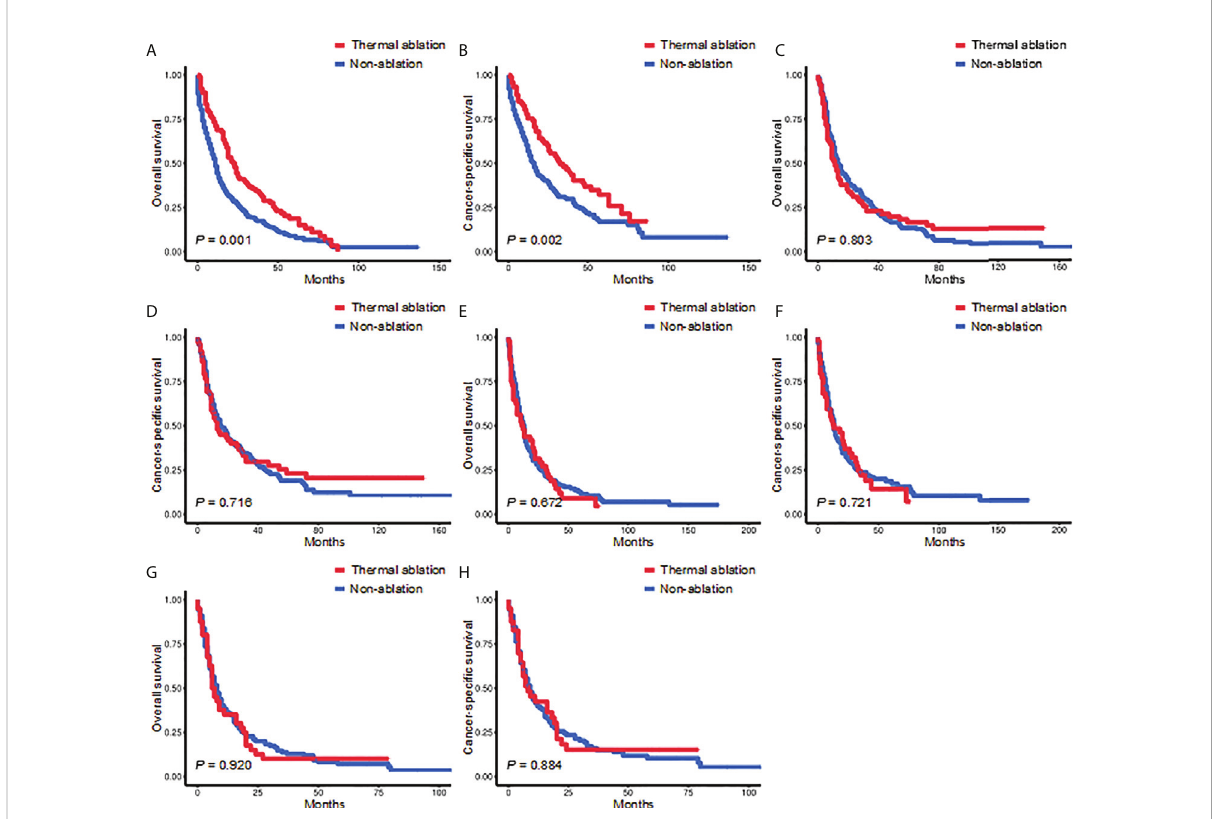
FIGURE 3 Kaplan-Meier survival curves for the TA and non-ablation groups when tumor size was ≤ 3.0 cm (A, B) , 3.1-5.0 cm (C, D) , 5.1-7.0 cm (E, F) , or >7.0 cm (G, H) after PSM. TA, thermal ablation; PSM, propensity score